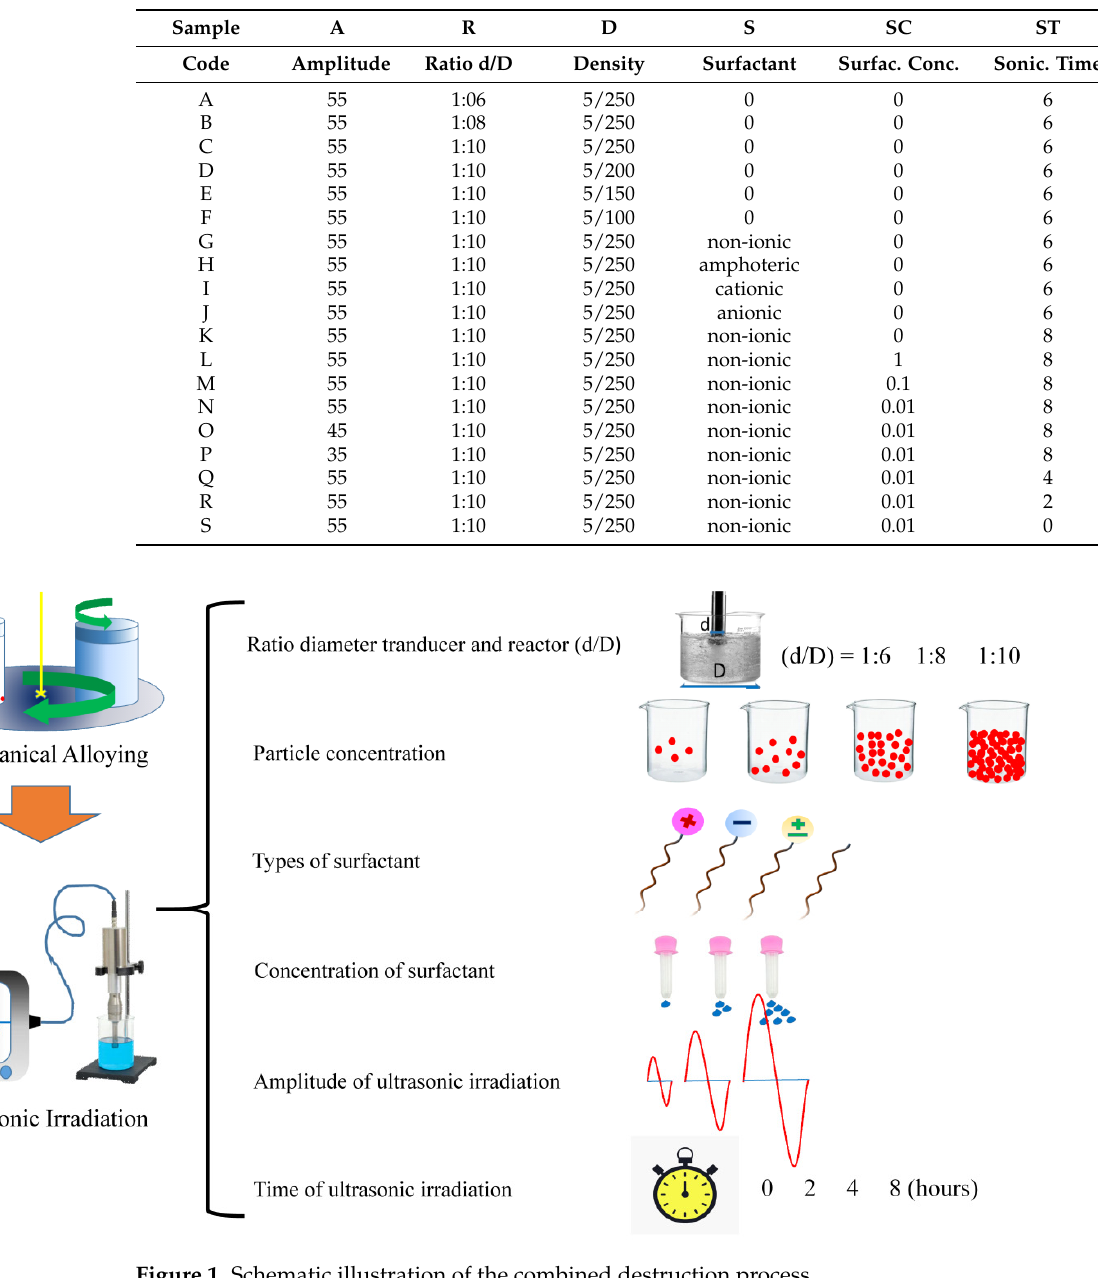
Table 1. Parameters of the sample treatment process.